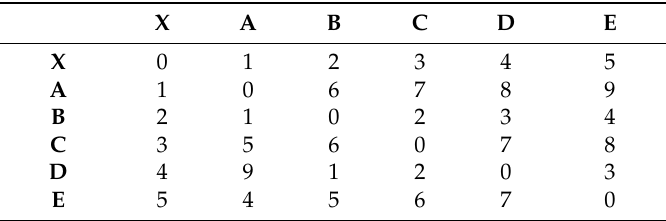
Table 5. Asymmetric cost matrix for mTSP with five cities.